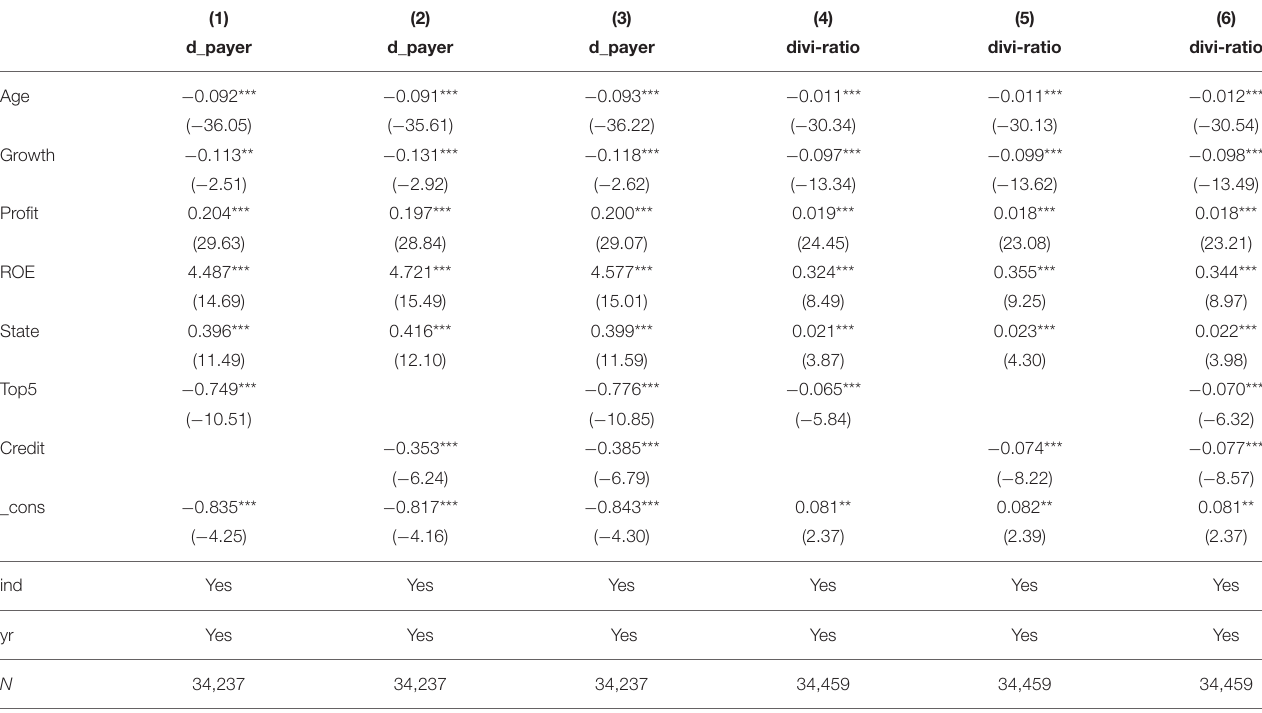
TABLE 2 | Supplier relationship strategy top5/credit and dividend payout propensity (logit), dividend payout level (Tobit) regression